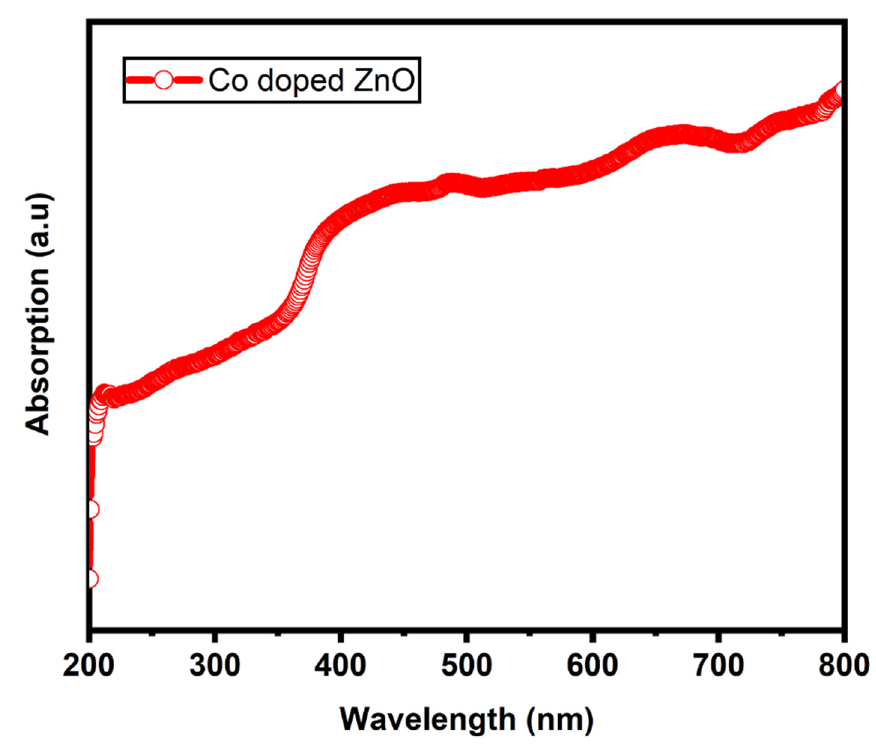
Figure 6. UV-vis absorption spectra of cobalt-doped ZnO microcrystals (MCs).